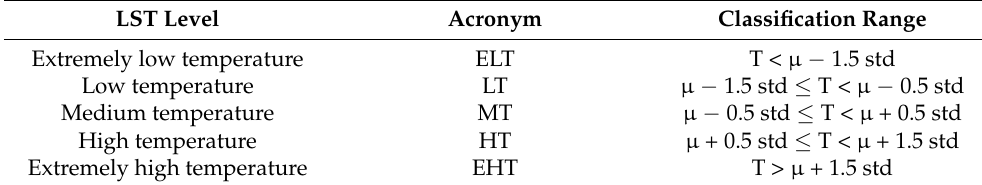
Table 2. LST classification level table.